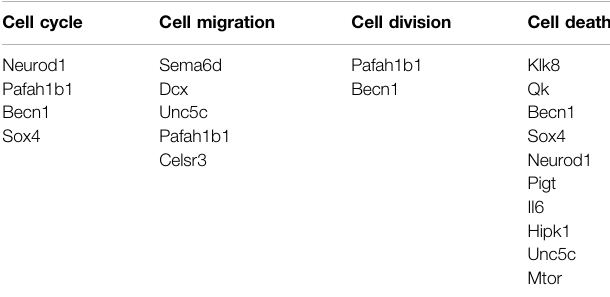
TABLE 3 | Target genes of the DE miRNAs in C1KO mice, as compared to WT mice, and corresponding GO terms.